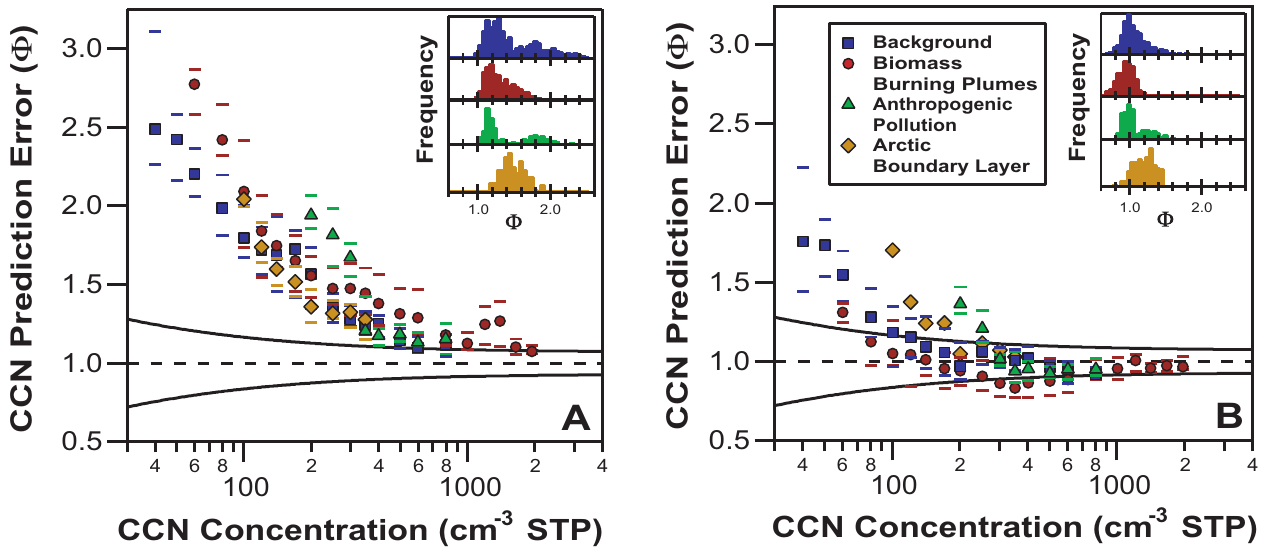
Fig. 10. CCN prediction error for 0.1–0.3% supersaturation versus measured CCN concentrations. Predictions were computed assuming that the aerosol is (a) internally-mixed, or (b) externally-mixed. Organic species are assumed to be soluble with κ = 0.11. Markers denote the median error for each air mass type, and bars denote the interquartile range. The dotted line at Φ =1 denotes perfect agreement and the solid bounding curves denote the CCN measurement uncertainty. The inset shows the frequency distribution of Φ for all 0.1 Hz data points.